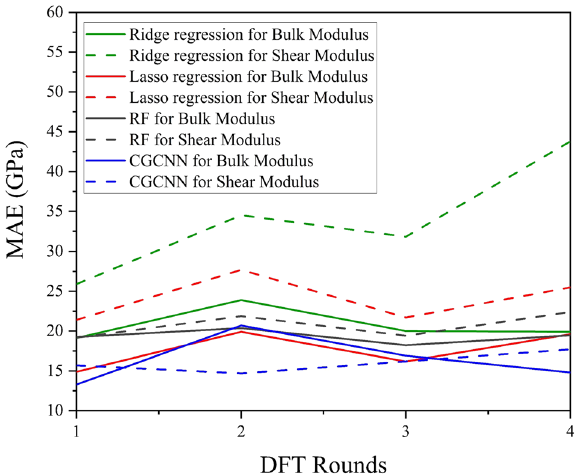
Fig. 4 Performance of traditional ML models. Mean absolute error (MAE) for Ridge regression, Lasso regression, Random Forest, and CGCNN models for bulk and shear moduli prediction at each DFT round.